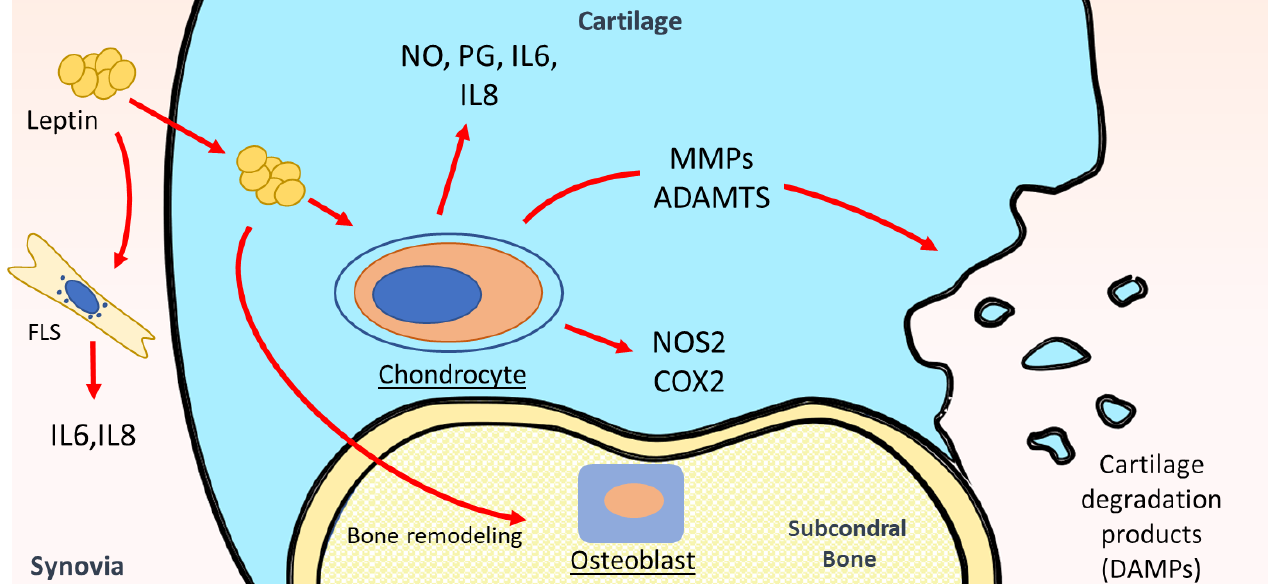
Figure 1. Leptin impact in OA pathophysiology. Leptin modulates the inflammatory environment in the joint, the imbalance between catabolic and anabolic factors, and remodeling of bone and cartilage. It also activates chondrocytes and production of pro-inflammatory mediators including IL-6, IL-8, NO, PG, NOS2, and COX2 and up-regulates metalloproteinases (MMP) production leading to extracellular matrix (ECM) degradation. It modulates cytokine production in synovial fibroblasts and bone remodeling imbalance exacerbating cartilage destruction and OA